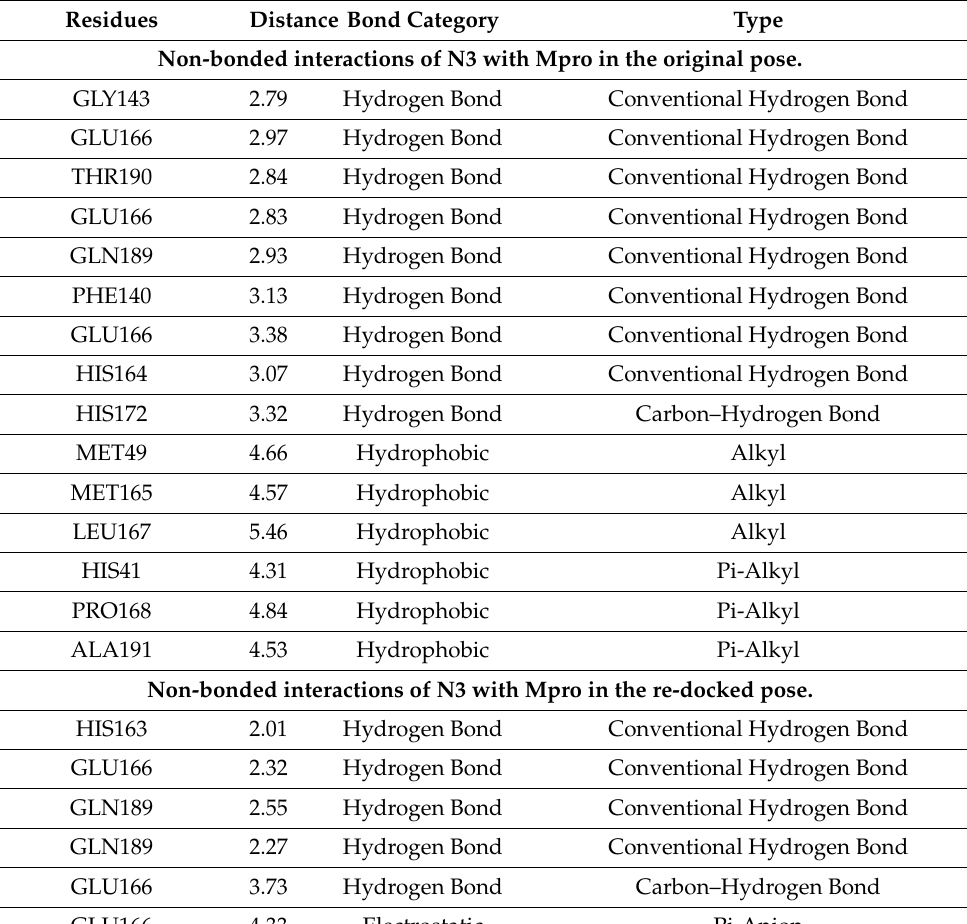
Table 7. Non-bonded interactions of N3 with Mpro in the pdb structure (PDB: 6LU7) in both original and re-docked pose. Residues Distance Bond Category Type Non-bonded interactions of N3 with Mpro in the original pose. GLY143 2.79